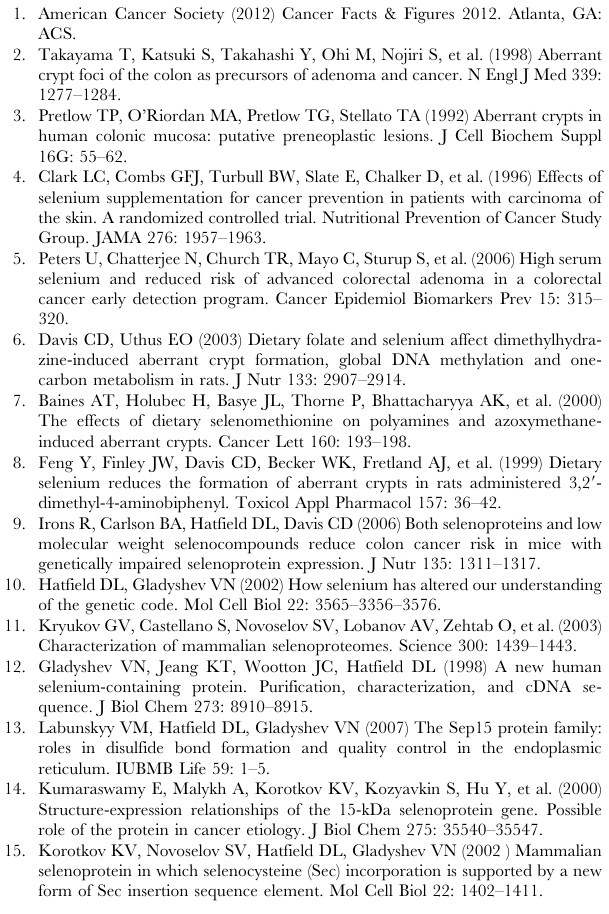
Figure 7. b -catenin protein expression in colonic epithelia of wild type (Sep15 + / + ) (N=4), heterozygous (Sep15 + / 2 ) (N=3) and Sep15 knockout (Sep15 2 / 2 ) mice (N=4) on 0.1 m g selenium/g diet. Cell lysates from colonic epithelia were loaded at 48 m g per lane. b -actin was used as the loading control.